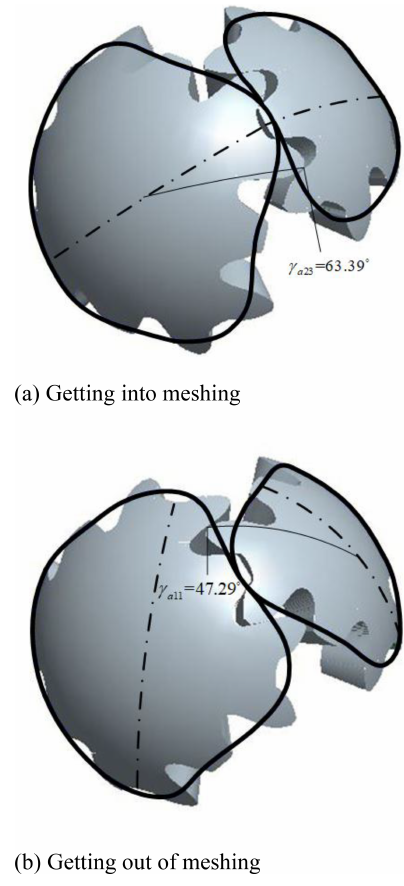
Figure 12. Meshing process (Case